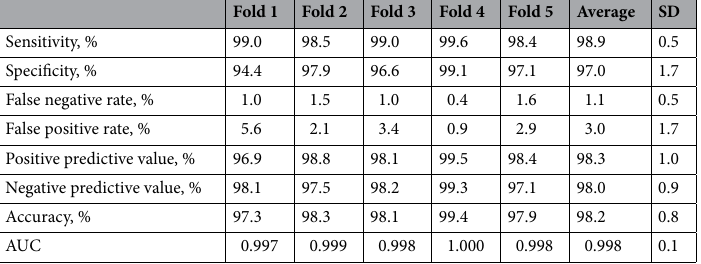
Table 2. Performance of the DL model in the training data set. AUC the area under the receiver operating characteristic curve, SD standard deviation.